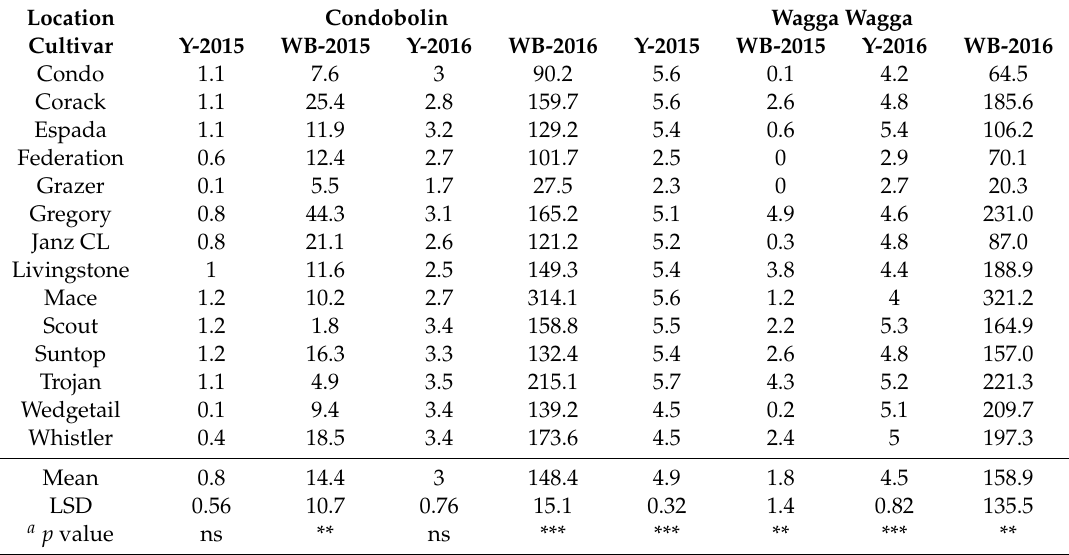
Table 5. Mean wheat cultivar grain yield (t / ha) and weed biomass (g / m 2 ) at crop maturity at Condobolin and Wagga Wagga in 2015 and